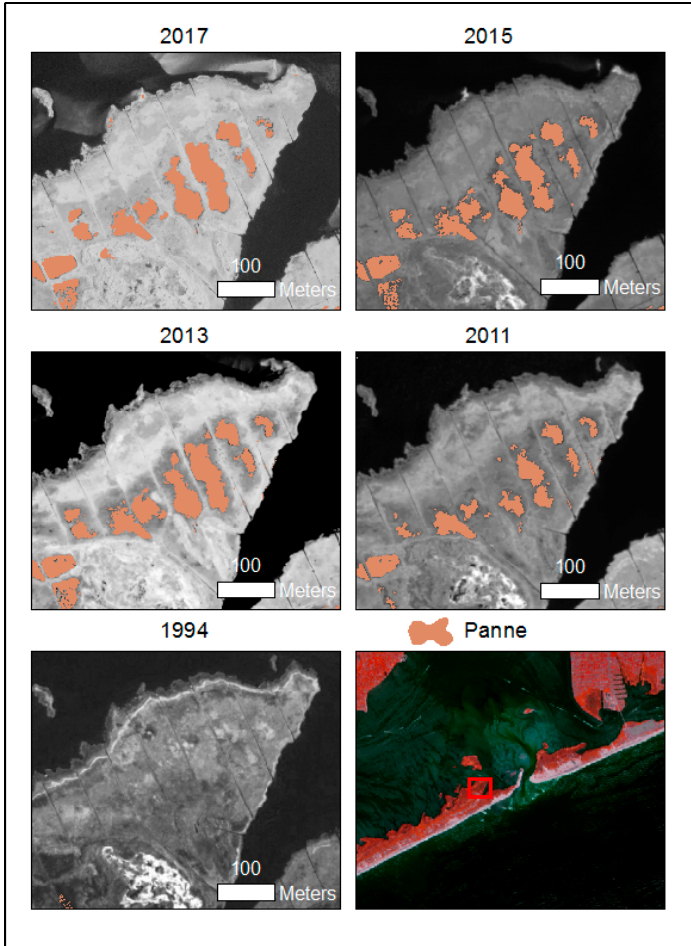
Figure 7. Panne classification from 1994 to 2017 for an area to the west of the old inlet breach. Each inset has the corresponding years NIR in panchromatic or red band in 1994. The locus map is a Sentinel-2 image from 5/21/2016.